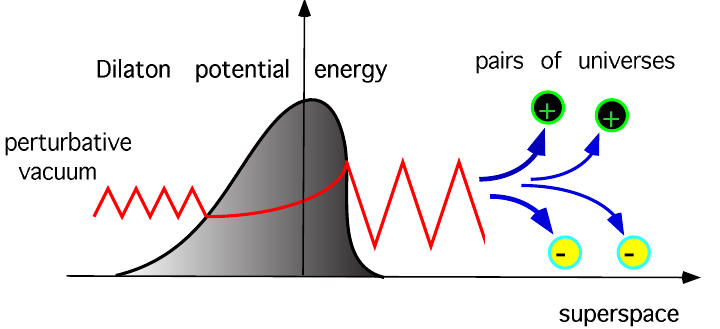
Figure 3. Birth of the universe represented as an anti-tunneling (parametric amplification) effect of the wave function in superspace, or – in the language of third quantization – as a process of pair production from the string perturbative vacuum.